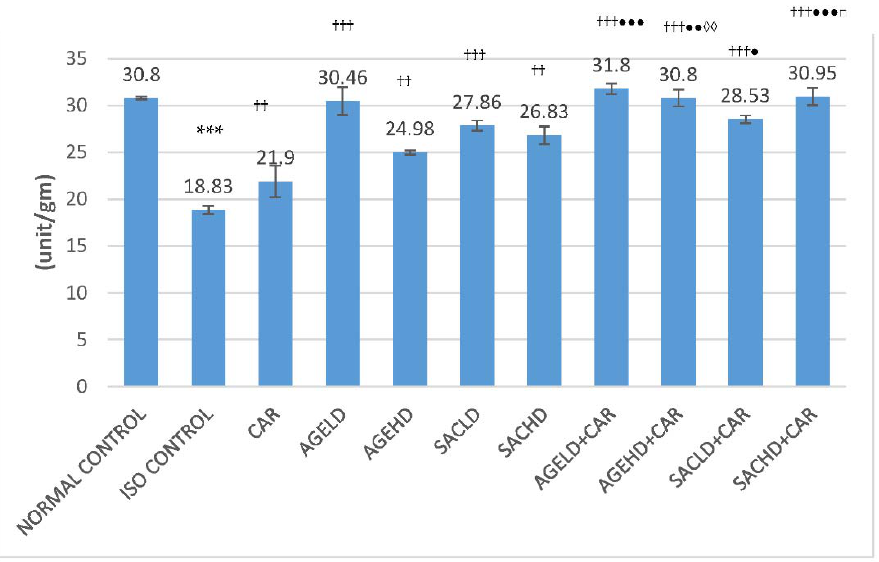
Figure 5. Effect on CK-MB activities in heart tissue homogenate. The data are given as mean ± SEM; *** p < 0.001 compared with normal control; †† p < 0.01, ††† p < 0.001 in comparison with ISO control; • p < 0.05, •• p < 0.01, ••• p < 0.001 in comparison with carvedilol; ♦♦ p < 0.01 when compared with respective AGE dose; □ p < 0.05 when compared with respective SAC dose.